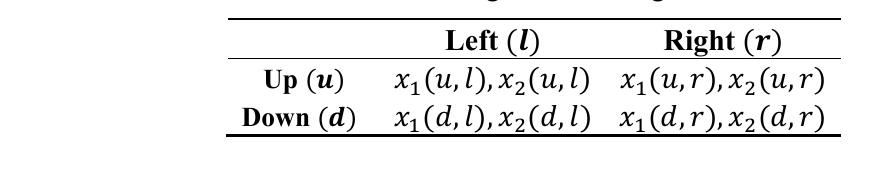
Table 1. A generic 2 × 2